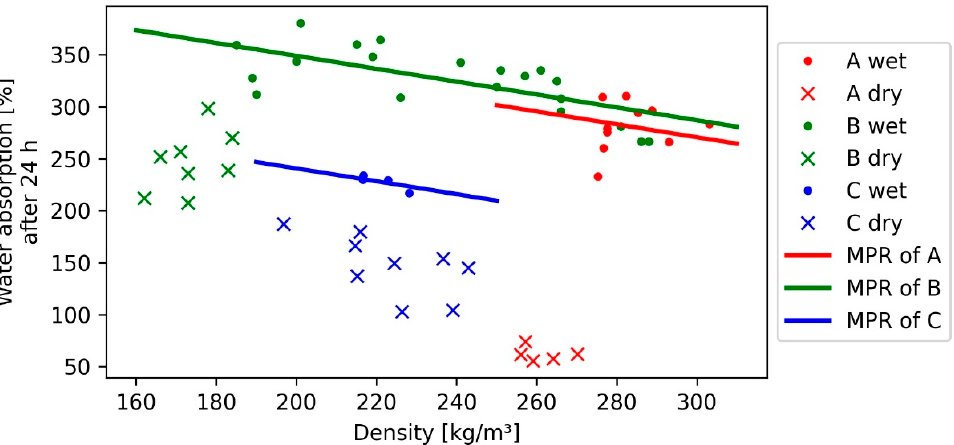
Figure 4. Polynomial regression (MPR) of water absorption after 24 h for each bark fibre length class (FLC) with the density; only the regression for wet samples is depicted.